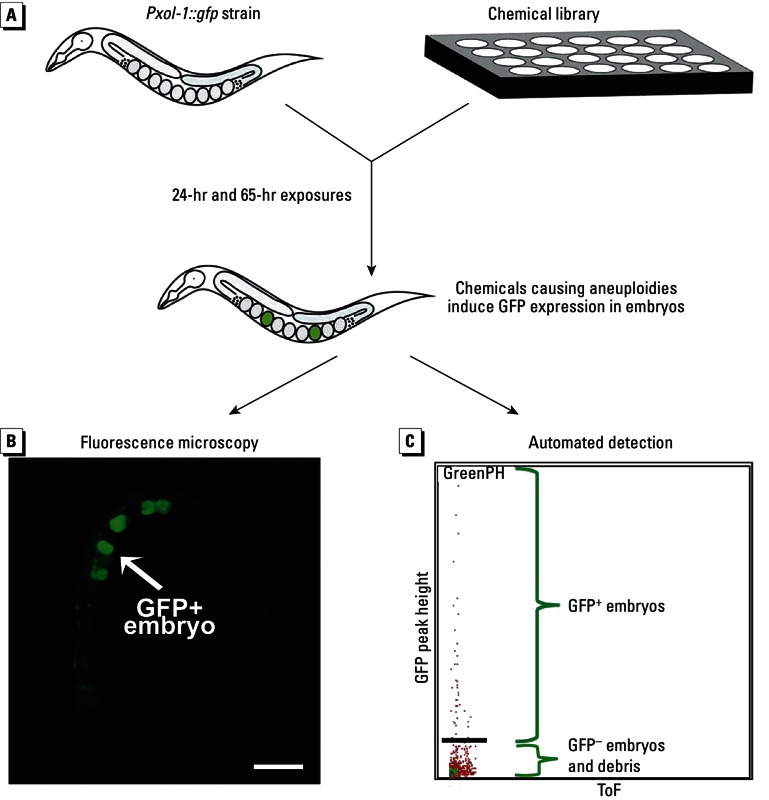
Design of the screening platform. (A) Worms from the aneuploidy-reporting Pxol-1::GFP strain are exposed to libraries of environmental compounds for either 24 hr or 65 hr. After exposure, the induction of aneuploidy can be visualized and quantified by fluorescence microscopy (B; bar = 100 µm) or automated detection and sorting of the worms (C). In B, several embryos expressing GFP (GFP+) can clearly be visualized. C shows automated reading of the embryos. A population of GFP+ embryos can be detected as distinct from GFP– embryos and debris, which appear below the black bar.